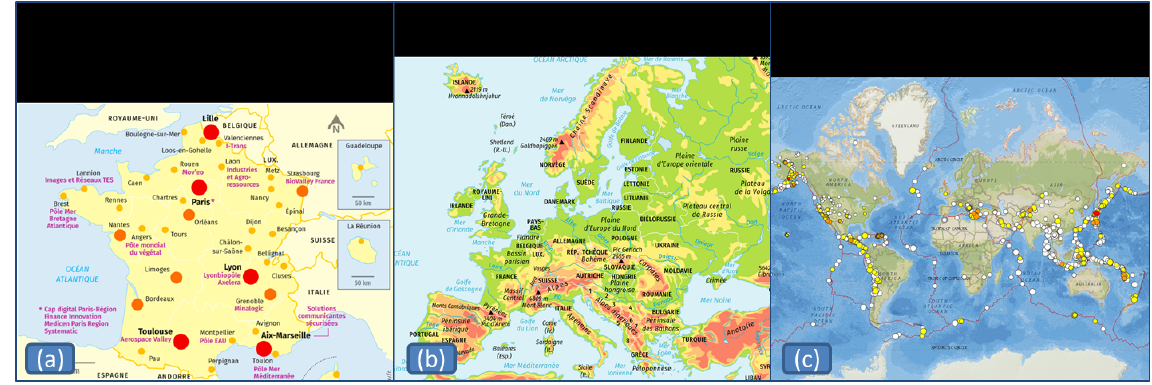
Figure 2: Three maps of at different categories of scale: (a) country (b) continent (c) world.